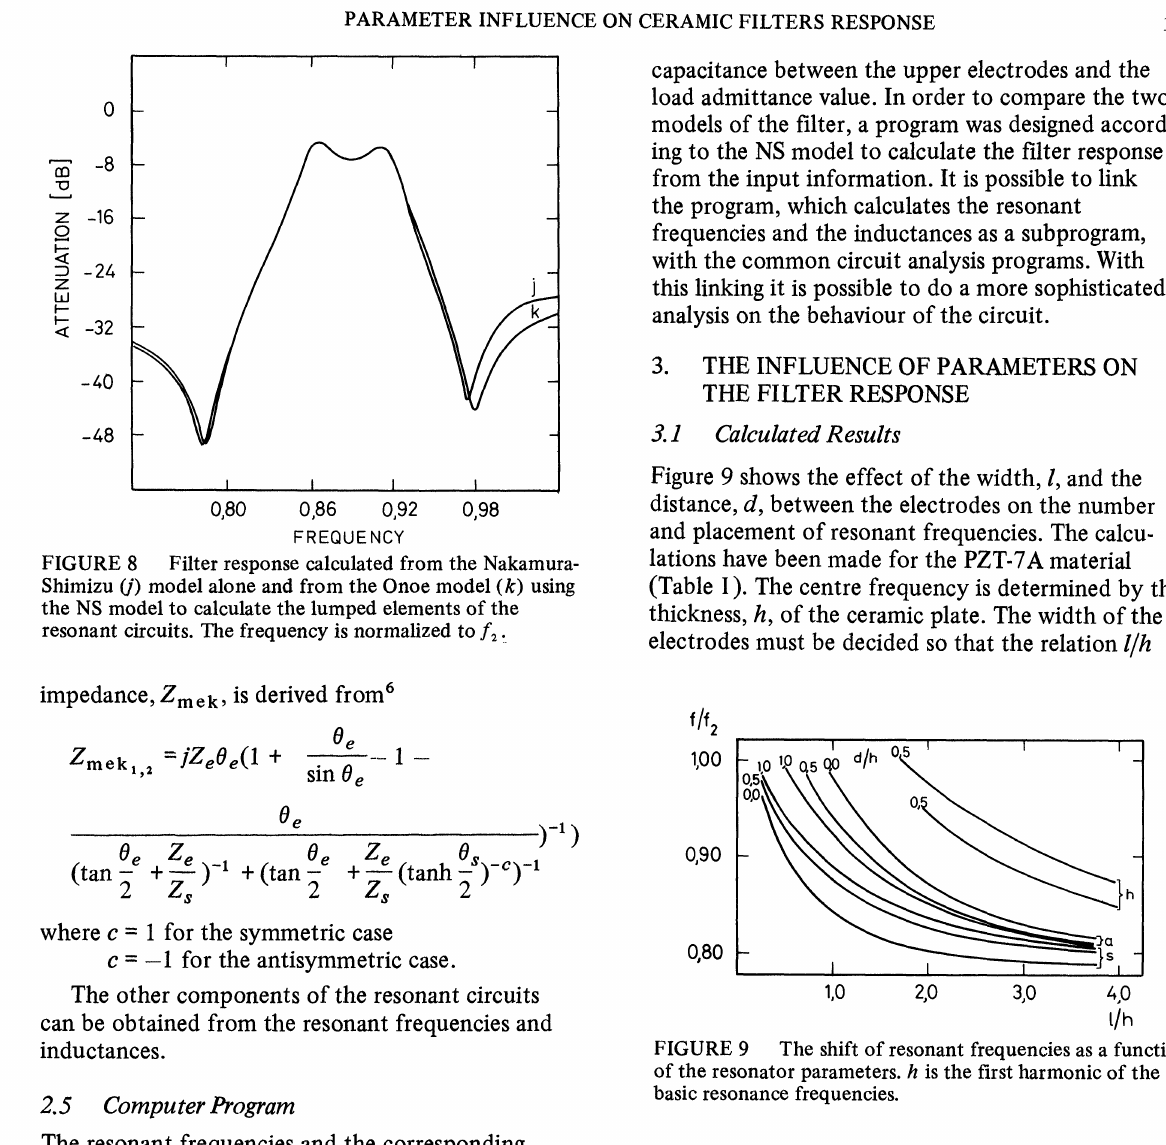
The shift of resonant frequencies as a function of the resonator parameters, h is the first harmonic of the basic resonance